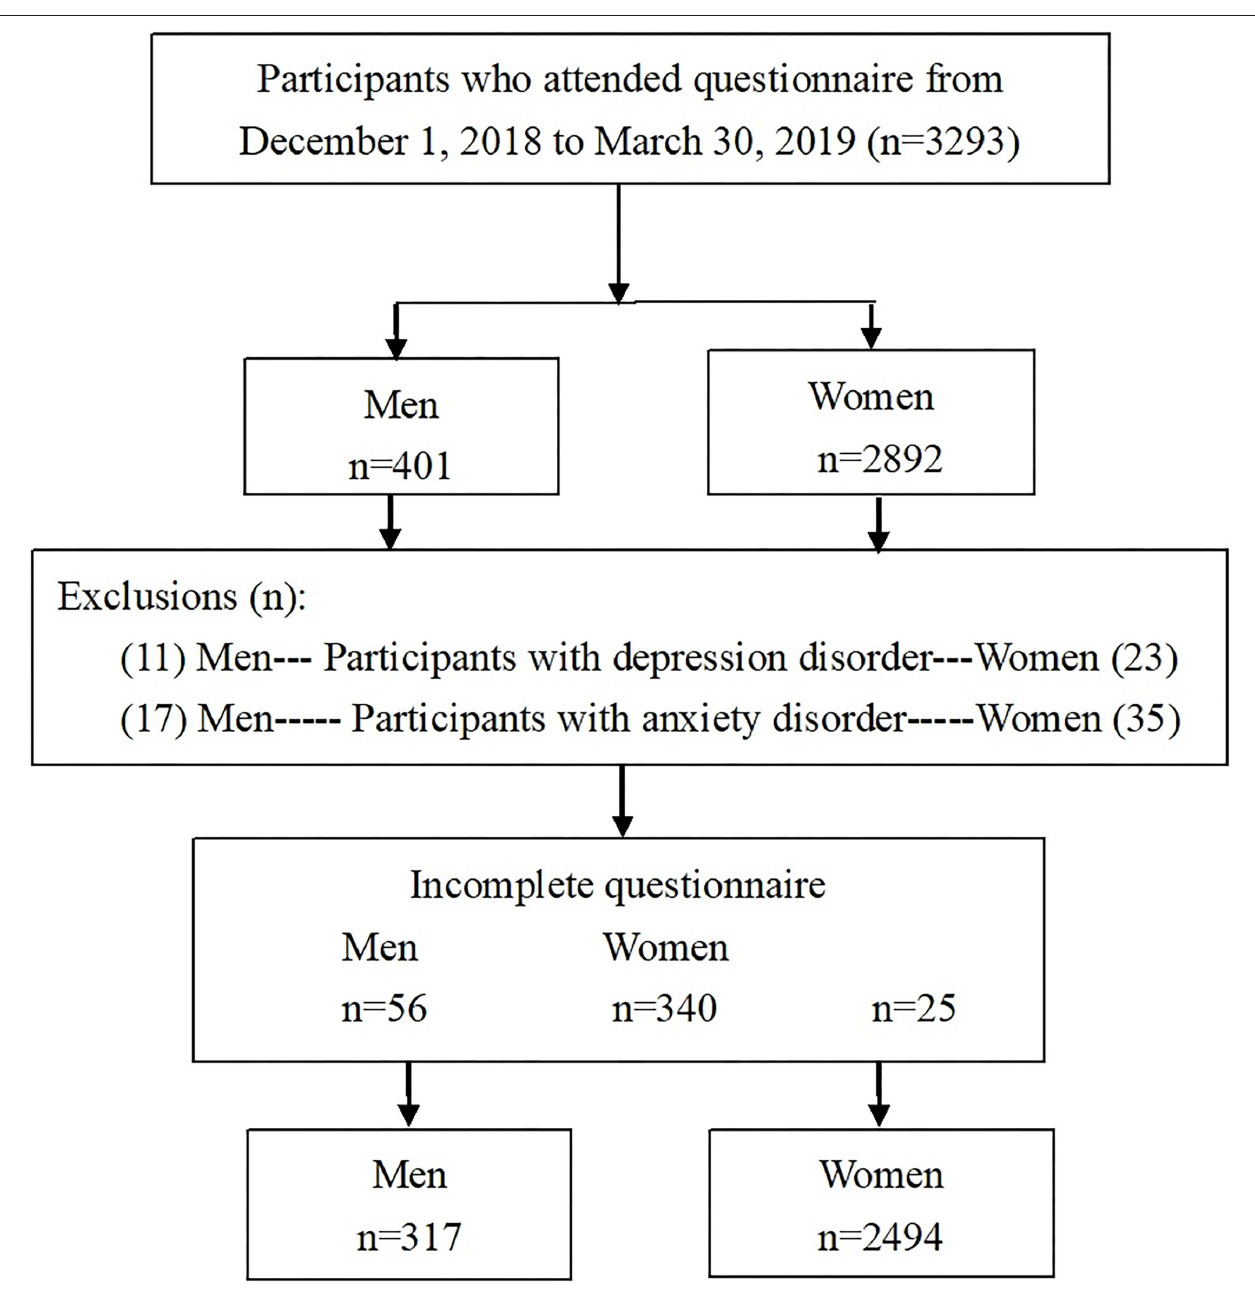
FIGURE 1 | Selection process of